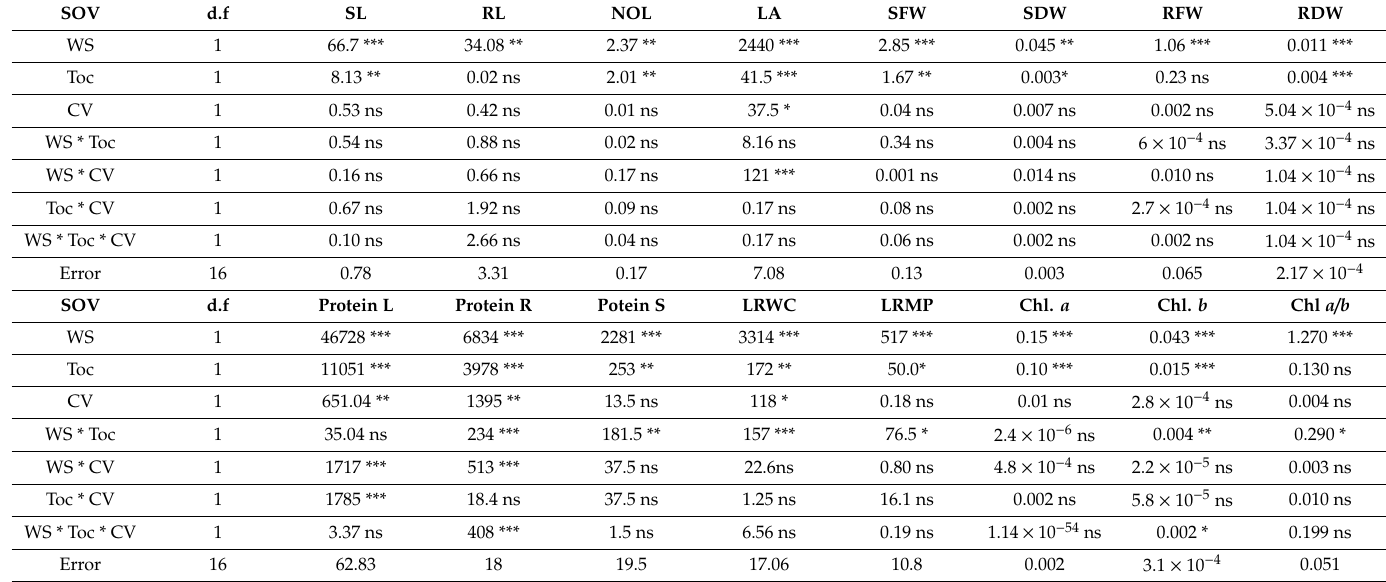
Table 2. Mean squares from analysis of variance of the data for the studied attributes of water stressed maize plants foliar-applied with α -Toc at seedling stage.